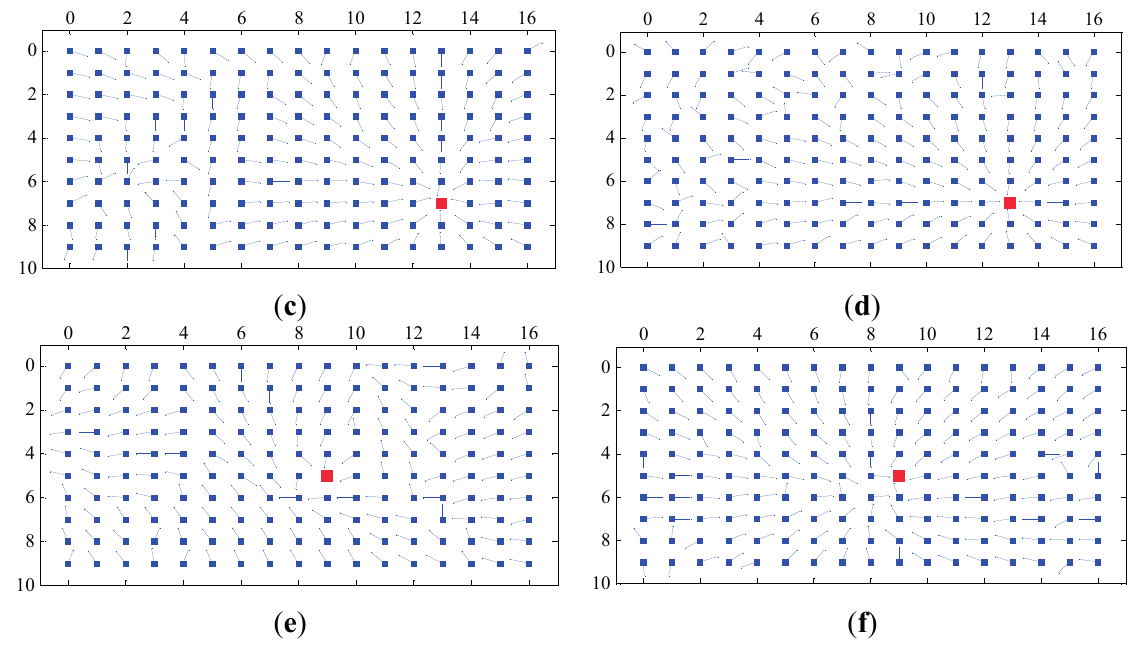
Figure 7. Homing vector fields. ( a , c , e ) The homing vectors generated by the warping method; ( b , d , f ) the homing vectors generated by the proposed homing method.